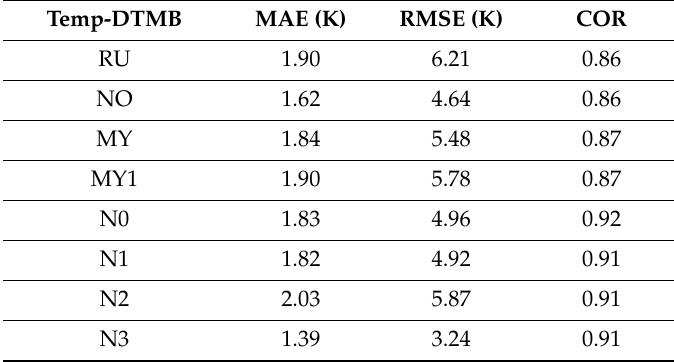
Table A2. Mean absolute error (MAE), root mean square error (RMSE), and correlation coe ffi cient (COR) for surface temperature (Temp) at Habib Bourguiba (Tunisia); meteorological aviation reporting (METAR) station code = DTMB.